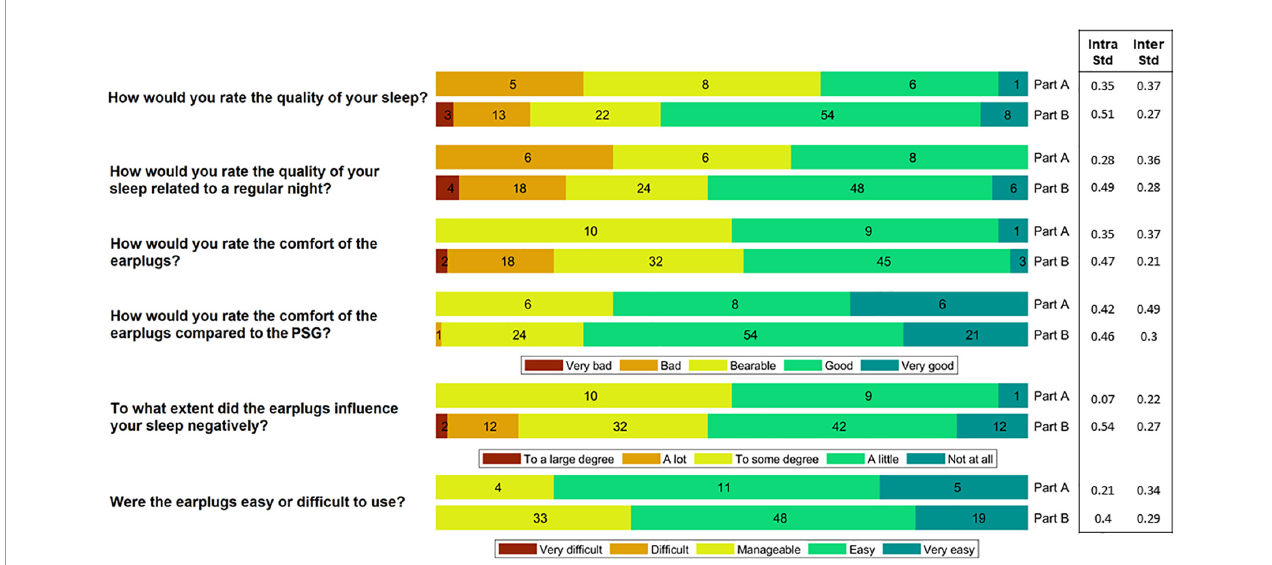
FIGURE3 The participants rated the comfort and ease-of-use of the device after each night. In Part A, they slept wearing both the polysomnography (PSG) setup and the earpieces, whereas in Part B they only wore the earpieces. This figure shows a summary of their ratings. The numbers in the bars reflect the number of responses (20 in total for Part A and 100 in total for Part B). Inter subject variation (Inter Std) and Intra subject variation (Intra Std) are shown for each question-part combination.